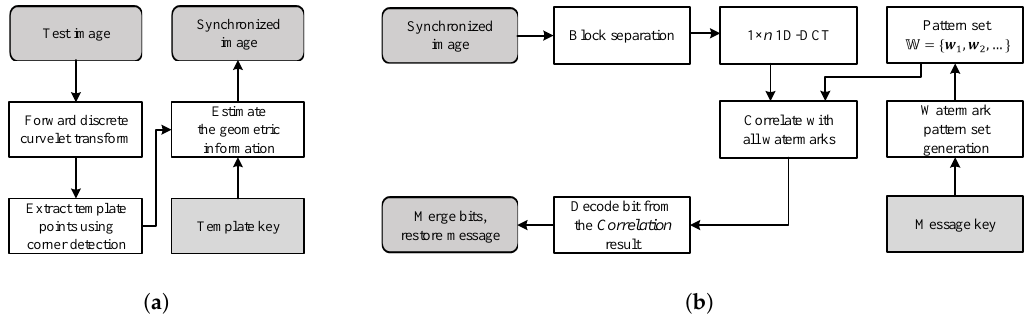
Figure 8. Proposed extraction process. ( a ) Template decoding and image recovery from geometric distortions; ( b ) message watermark